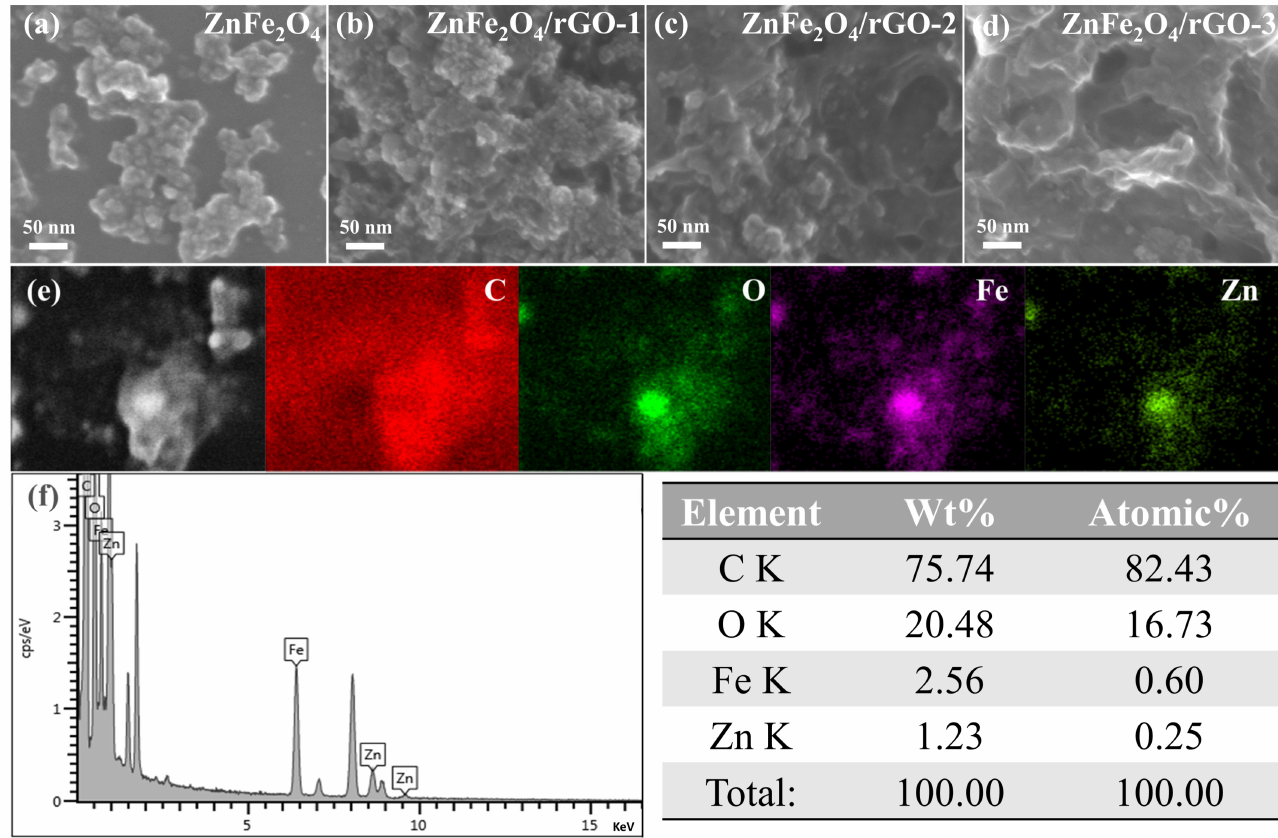
Figure 4. SEM images of ( a ) ZnFe 2 O 4 , ( b ) ZnFe 2 O 3 /rGO − 1, ( c ) ZnFe 2 O 3 /rGO − 2, and ( d ) ZnFe 2 O 3 /rGO − 3, ( e ) SEM elemental mapping, and ( f ) elemental content of ZnFe 2 O 4 /rGO − 2 nanocomposites. Transmission electron microscopy (TEM) and high-resolution TEM (HRTEM)